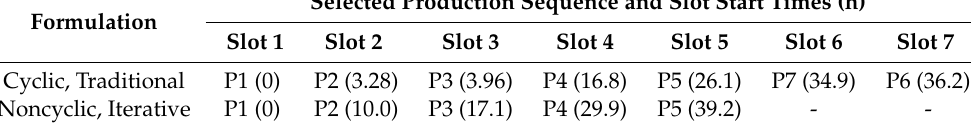
Table 13. Production schedule: Scenario